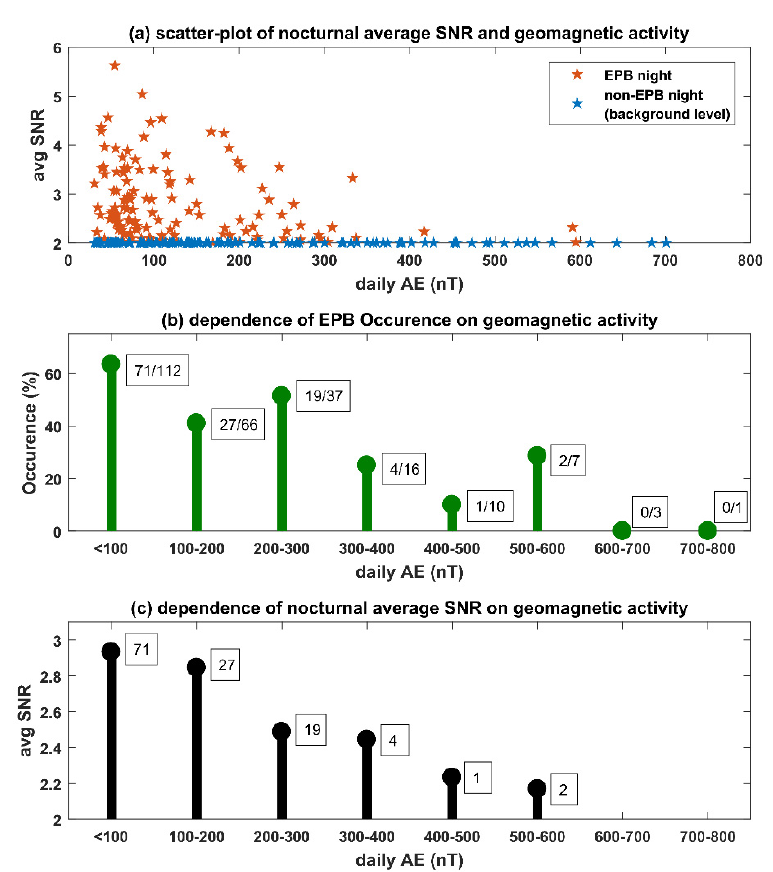
Figure 8. ( a ) Scatter plot of daily AE and nocturnal average SNR at 300 km for the entire equinoctial period considered in the study. Orange and blue colors indicate EPB and non-EPB nights, respectively. ( b ) EPB occurrence in the piece-wise incremental level of daily AE. Note, the box adjacent to each stem indicates the no. of EPB cases/total cases in each window. ( c ) Nocturnal average SNR (300 km) in the piece-wise incremental level of daily AE. Note that the average SNR is calculated only by considering EPB nights (no. indicated in adjacent box).